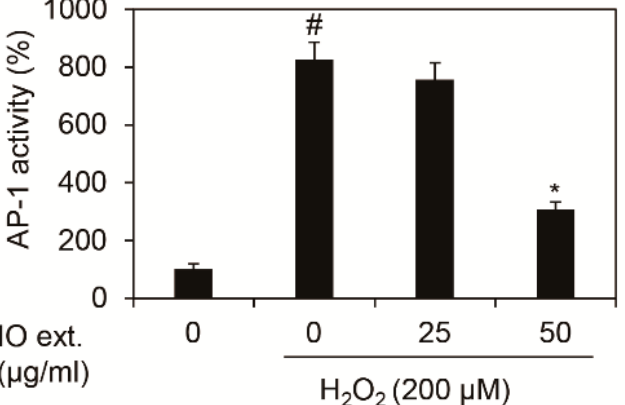
Figure 3. E ff ects of extracts of Inonotus obliquus on promoter activity of TRE in human dermal fibroblasts. TRE activity was estimated by using TRE-luciferase reporter assay. TRE activity was normalized to β -galactosidase. The graphs are expressed as the mean ± S.D. from triplicate experiments. # p < 0.05 compared with non-treated cells. * p < 0.05 compared with 200 µ M H 2 O 2 -treated cells.